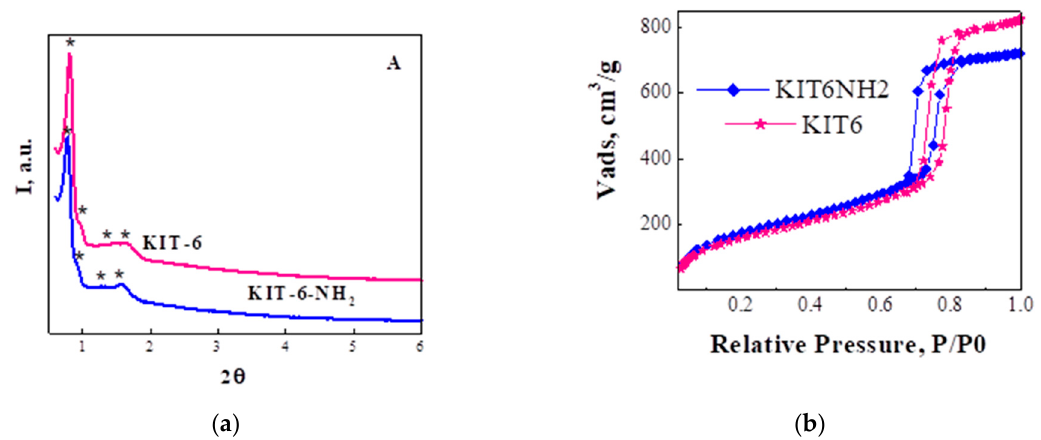
Figure 1. ( a ) XRD patterns at small angle and ( b ) N 2 adsorption desorption of KIT-6 mesoporous nanoparticles before and after functionalization.